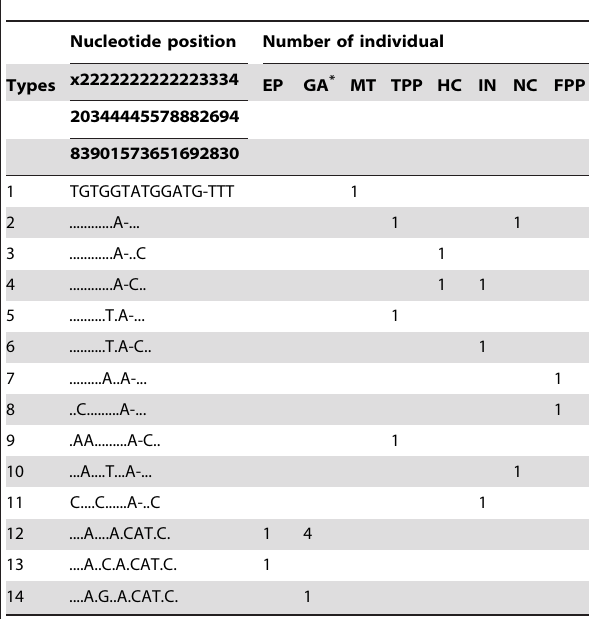
Figure 3. Neighbor-joining phylogenetic tree drawn using 1,103 bp COI sequences of 91 individuals of Panulirus penicillatus collected in the Eastern (EP), Central (CP) and Western Pacific (WP). Operational outgroup, Panulirus japonicus (NC_004251) [21] is not shown due to much longer branch than those within P. penicillatus . Bootstrap supports higher than 50% and numbers with branches indicate probability for 1,000 replications. Larval samples are shown in red. Samples carrying asterisk are from Central Pacific.